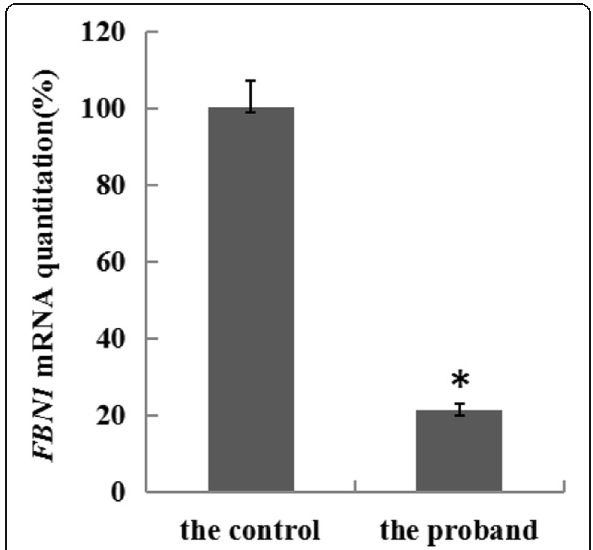
Fig. 6 Relative expression level of FBN1 gene of the proband is only about 21% compared to the control group. β -actin was a reference gene for analyses. The data represented the means of three independent experiments done in duplicates. P -value was assessed using a T-test. Significance p < 0.05 is indicated by (*); * p < 0.05 vs.